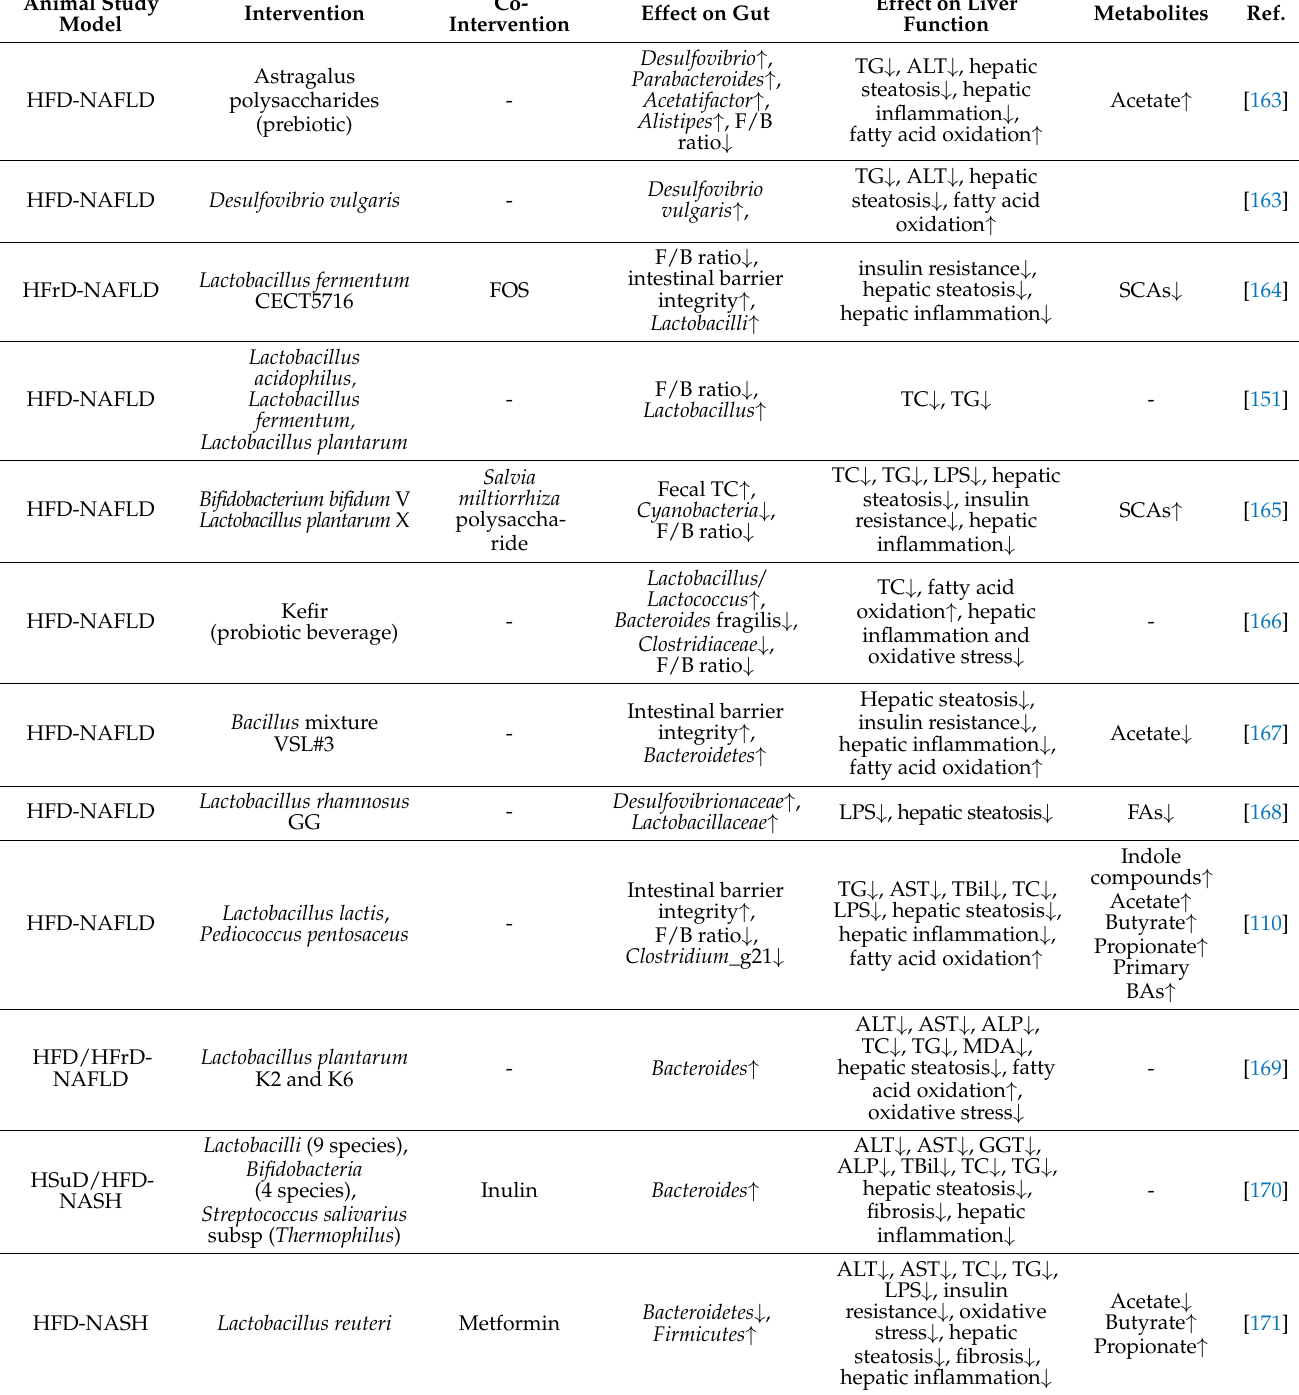
Table 1. Microbiota-based preclinical studies in non-alcoholic fatty liver